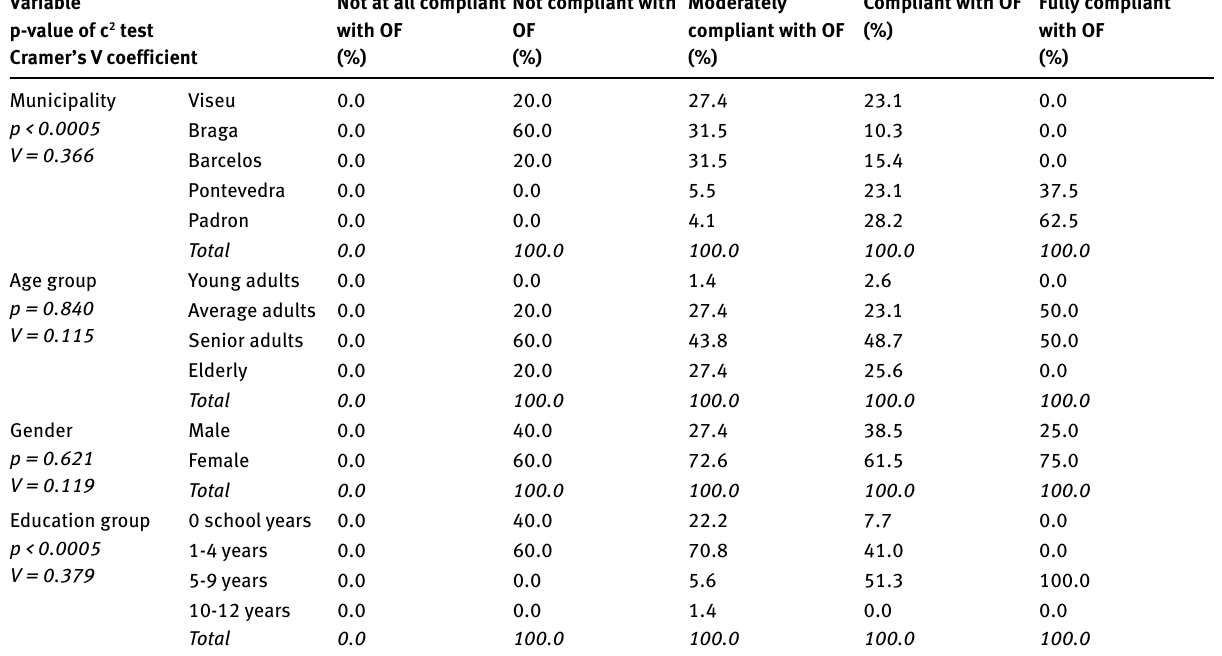
Table 2: Associations between the variable compliance with OF regarding soil management and preparation (CPOF-S) and the socio-demo- graphic